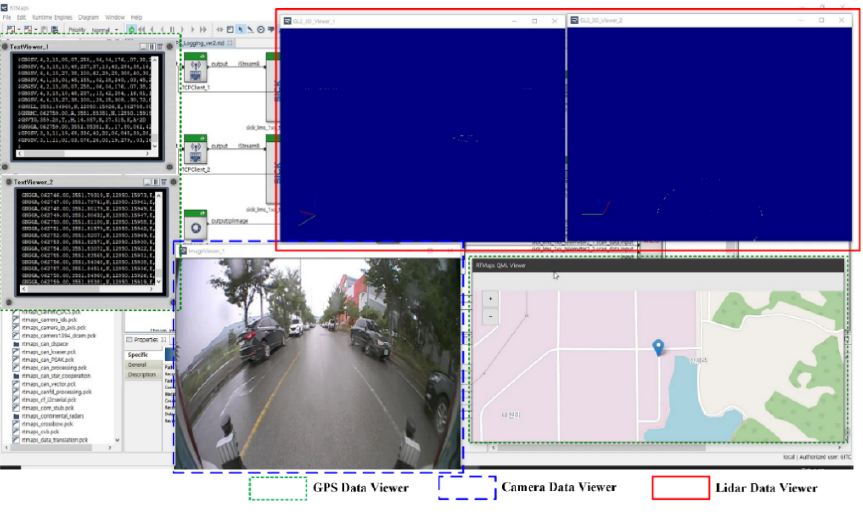
Figure 13. Real-time driving data results using the logging system with multiple sensors (GPS, camera, and LIDAR).